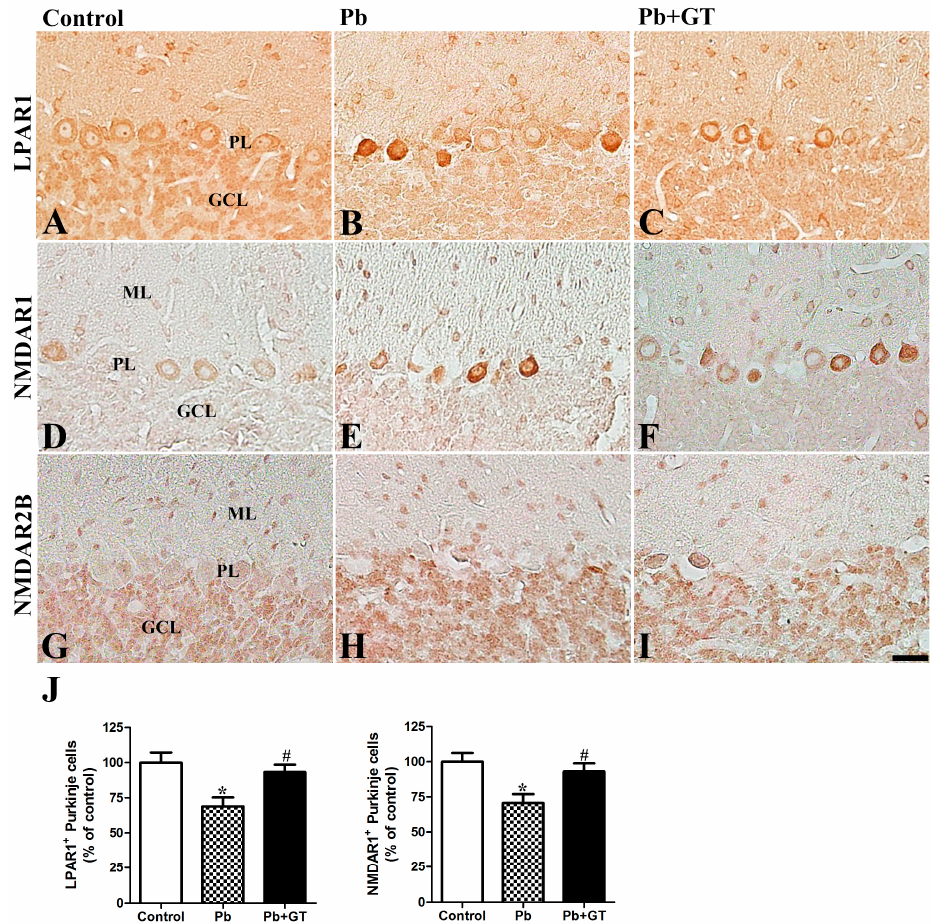
Figure 4. E ff ects of gintonin on Pb-induced changes in cerebellar LPAR1 and NMDA receptor expression. Immunohistochemistry of LPAR1 ( A – C ), NMDAR1 ( D – F ), and NMDAR2B ( G – I ) in the cerebellum of o ff spring from control, Pb, and Pb plus gintonin (Pb + GT) groups. LPAR1 and NMDAR1 are mainly detected in the Purkinje cell layer, and NMDAR2B is detected in the granular cell layer in the cerebellar cortex. The number of LPAR1-immunoreactive and NMDAR1-immunoreactive intact Purkinje cells is significantly reduced, while gintonin treatment ameliorated this reduction in the cerebellum. GCL, granular cell layer; ML, molecular layer; PL, Purkinje cell layer. Bar = 25 µ m. ( J ) Numbers of LPAR1-immunoreactive Purkinje cells ( p = 0.0031, one-way analysis of variance) and NMDAR1-immunoreactive Purkinje cells ( p = 0.0042, one-way analysis of variance) are expressed as a percentage of the value in the control group in the cerebellar cortex (n = 12 per group). * p < 0.05, compared to control group; # p < 0.05, compared to Pb alone, Tukey’s post-hoc test. The bars indicate means ± standard error of the